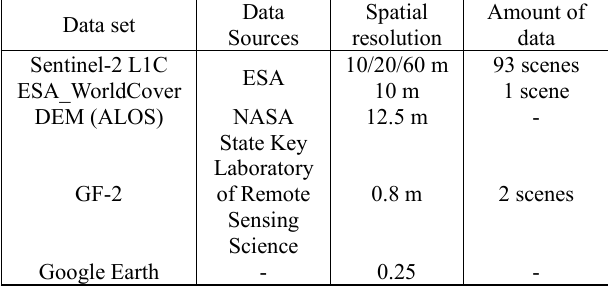
Table 1. Basic information of data.